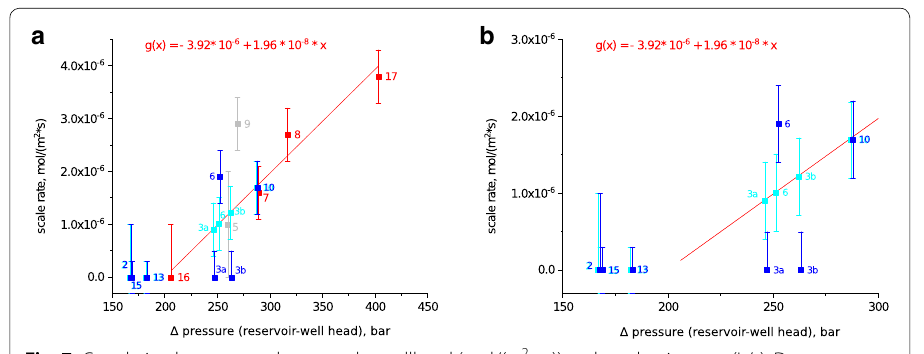
Fig. 7 Correlation between scale rate at the wellhead (mol/( m 2 · s)) and production rate (L/s). Data points labeled with site number. The dark blue data points are the observed scale rates of several facilities. The bright blue data points are scale rates of these facilities modeled by the regression g(x) - 3.92 · 10 − 6 1.96 · 10 − 8 · x based on (cid:31) pressure (x). a (left) shows also the red and grey data points = + used for the development of the regression while b (right) shows only the new blue data points used for validation. Observed and modeled values are identical for sites 2, 10, 13, and